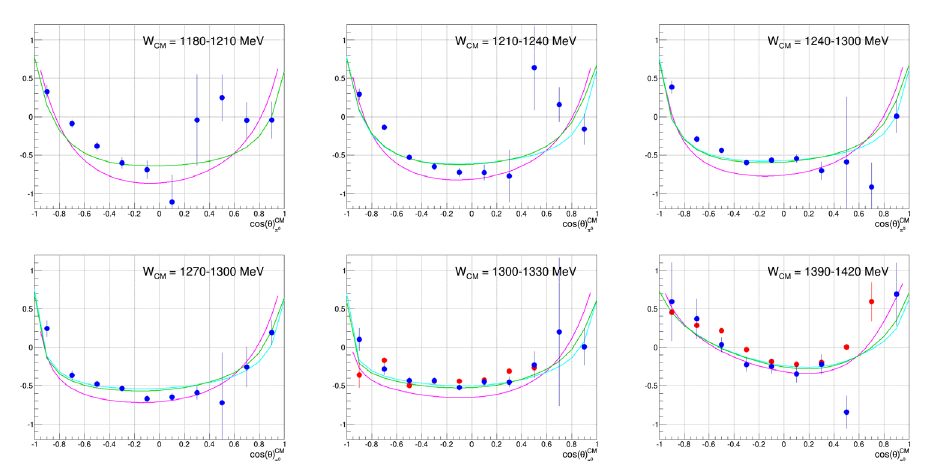
Figure 3. Double polarisation observable E for the single π 0 from quasi-free proton, the new data from A2 (blue point) cover the full A2 energy range. The new data are compared with [7] and with the theoretical model MAID 2007 for the free proton (magenta line). In order to take into account the fact that the nucleon in the deuterium target are quasi-free, additional corrections are applied to the free proton model: the impulse approximation correction (green line) and impulse approximation correction plus final state interaction (light blue line) based on the Fix-Arenhovel model